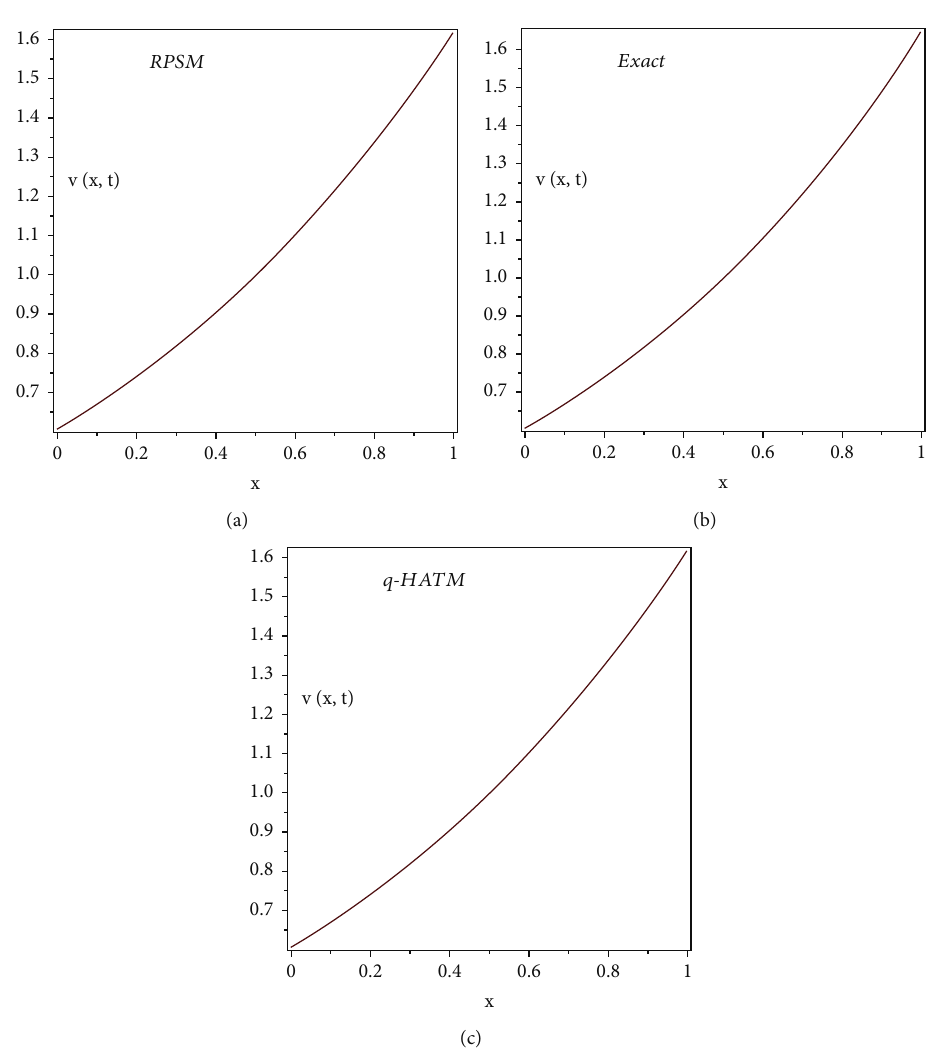
Figure 2: 2D plots of (a) RPSM, (b) Exact, and (c) q-HATM υ − solutions at δ = 1 of Example